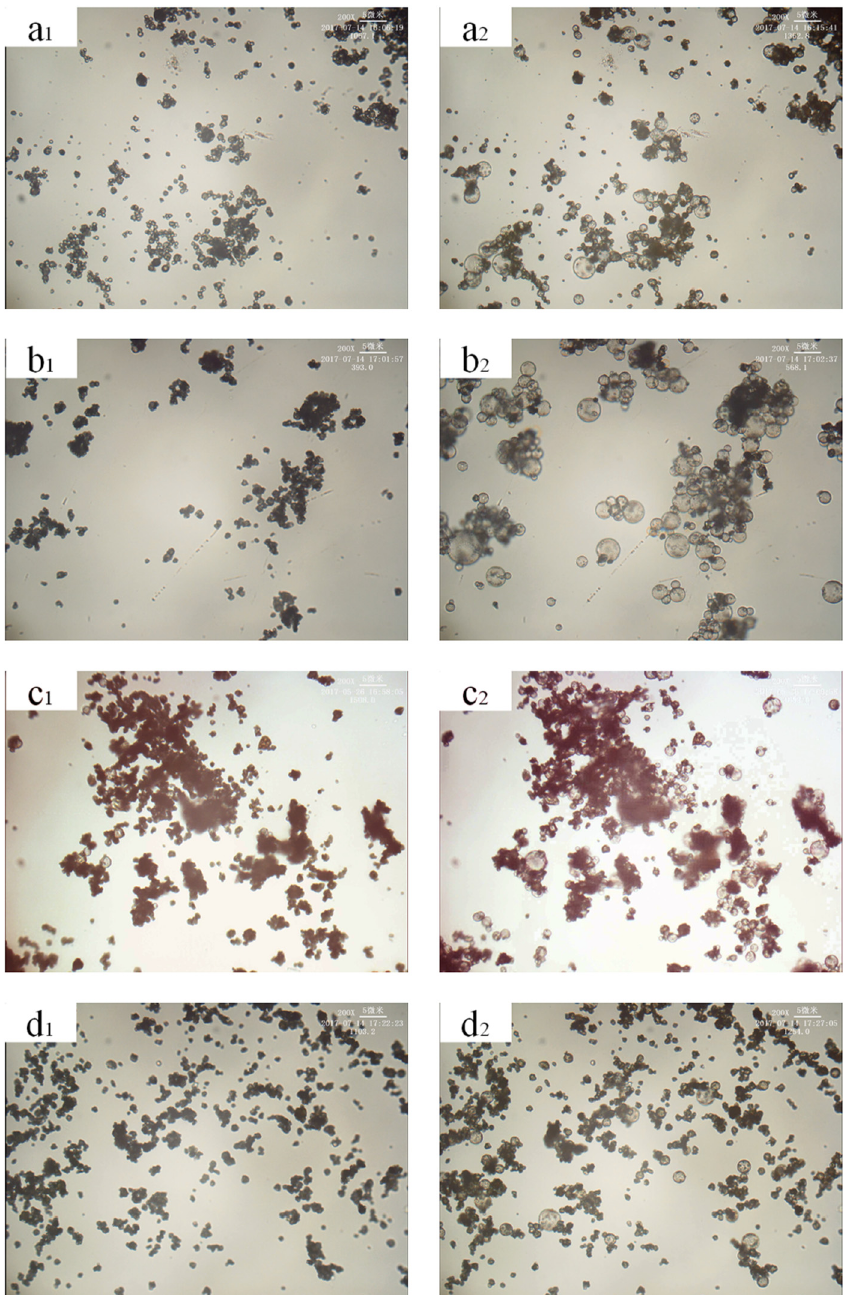
Figure 5: E ff ect of di ff erent content of crosslinking agents on the expansion properties of microspheres. ( a – d ) Crosslinking agent content: 0.29 wt%, 0.58 wt%, 0.87 wt%, 1.17 wt%. ( a 1 – d 1 ) Pre - expansion sample. ( a 2 – d 2 ) Expanded